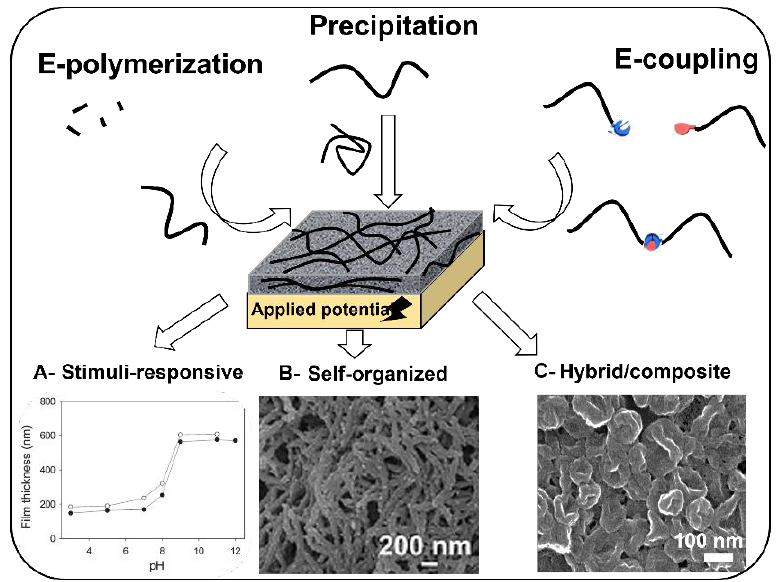
Figure 2. Film electrodeposition. Main approaches for electrochemically induced film formation include electropolymerization, electrochemically induced precipitation, and coupling. The resulting surface coatings containing weak polyelectrolytes combine pH responsiveness ( A ) with eventual self-organization ( B ) and combination with inorganic units ( C ). Figures ( A ) [60], ( B ) [61], and ( C ) [62] are reproduced with permission from the original articles.